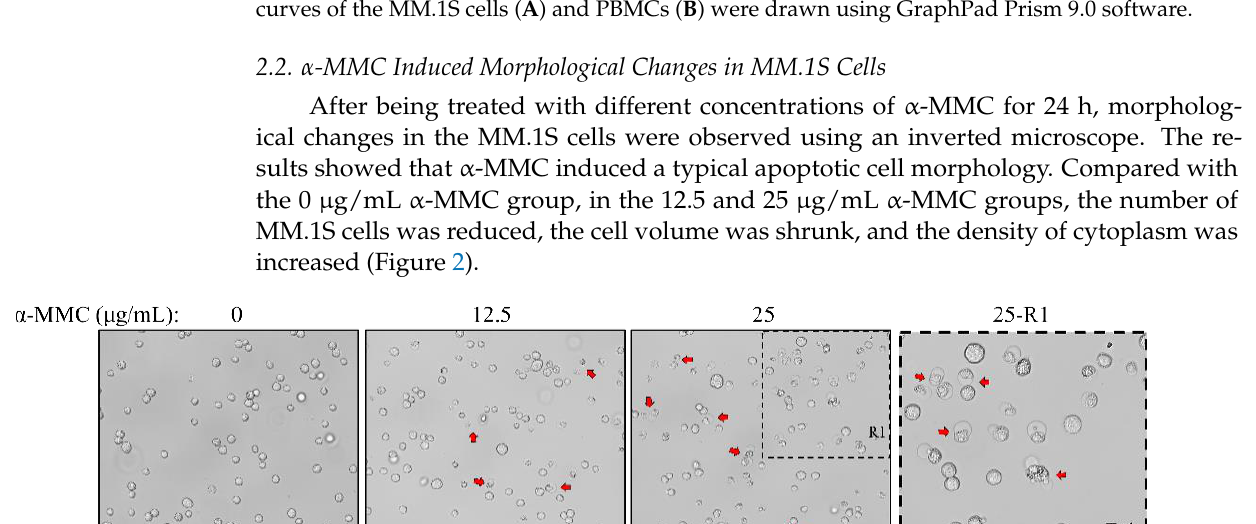
Figure 1. Growth inhibitory effect of α -MMC on MM.1S cells and PBMCs. The cells were treated with α -MMC for 24 and 48 h, and then the cell viability was detected using the CCK-8 method. The growth curves of the MM.1S cells ( A ) and PBMCs ( B ) were drawn using GraphPad Prism 9.0 software.